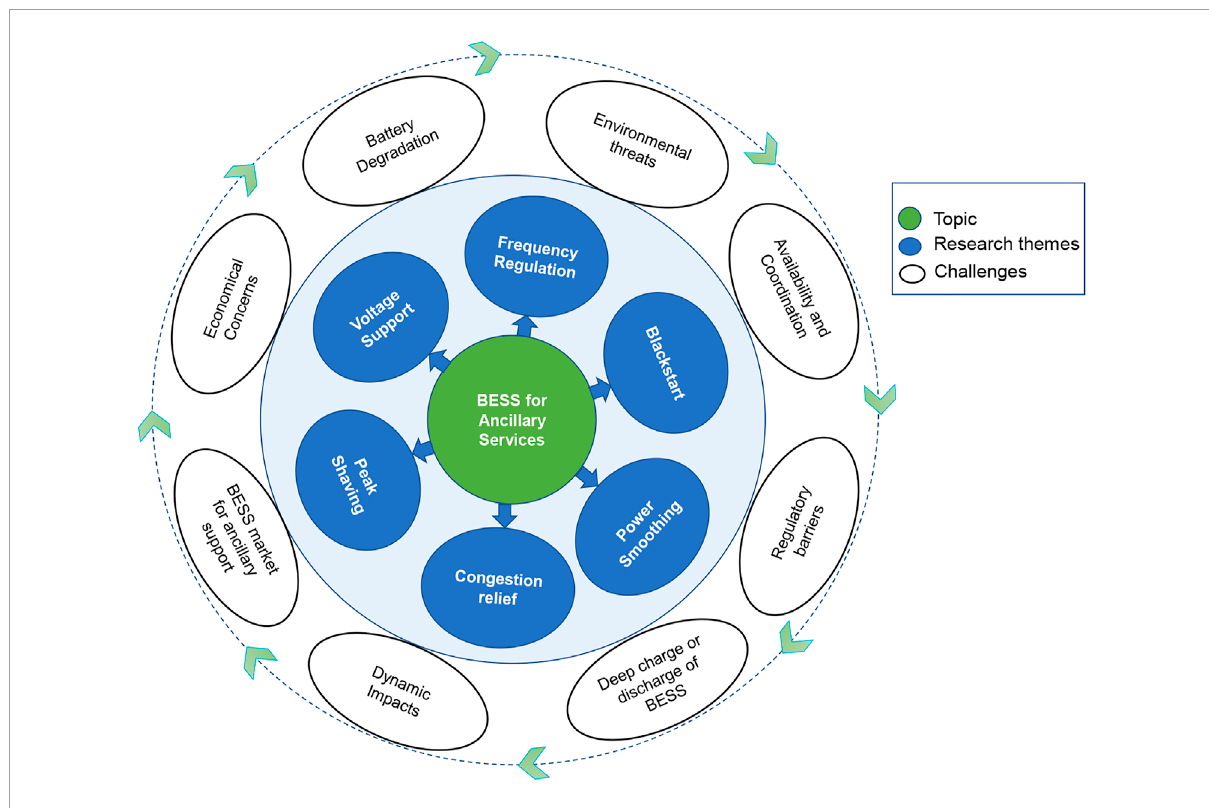
FIGURE 6 Challenges in deploying BESS.